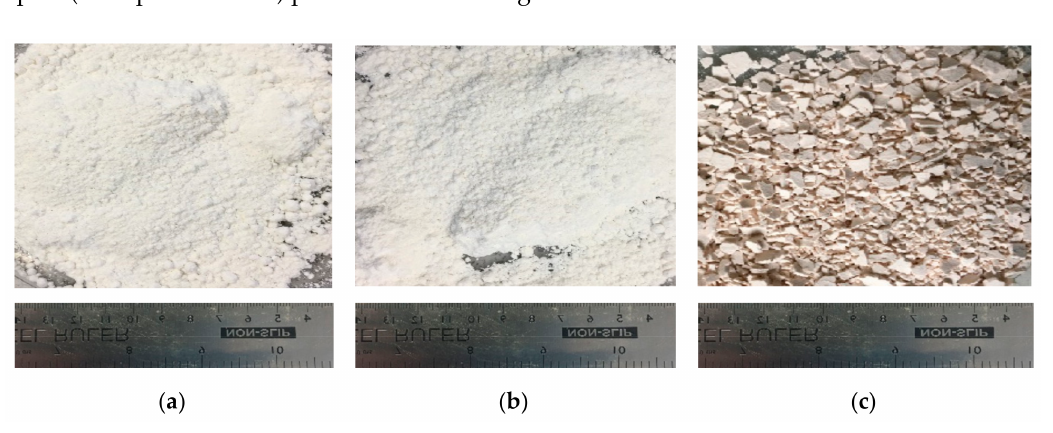
Figure 3. Photograph of ( a ) ASP, ( b ) HNTs, ( c ) ASP-loaded HNTs after drying in the oven at 40 ◦ C overnight. The resultant blend had a pale pink colour as compared to the white colour of the ASP and HNTs